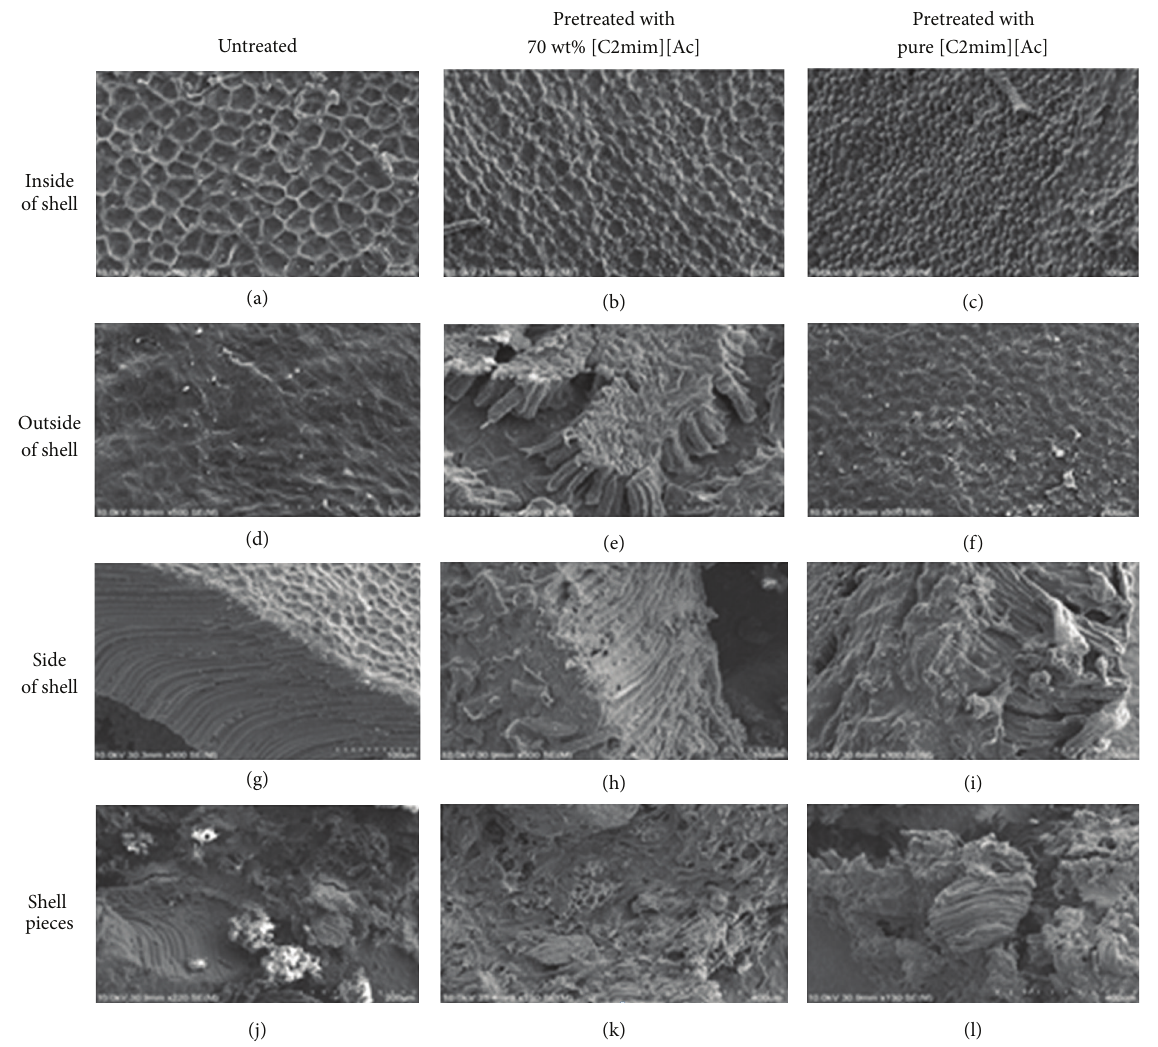
Figure 5: SEM images of jatropha shell taken at 100 𝜇 m, ((a)–(i)), 200 𝜇 m (j), and 400 𝜇 m